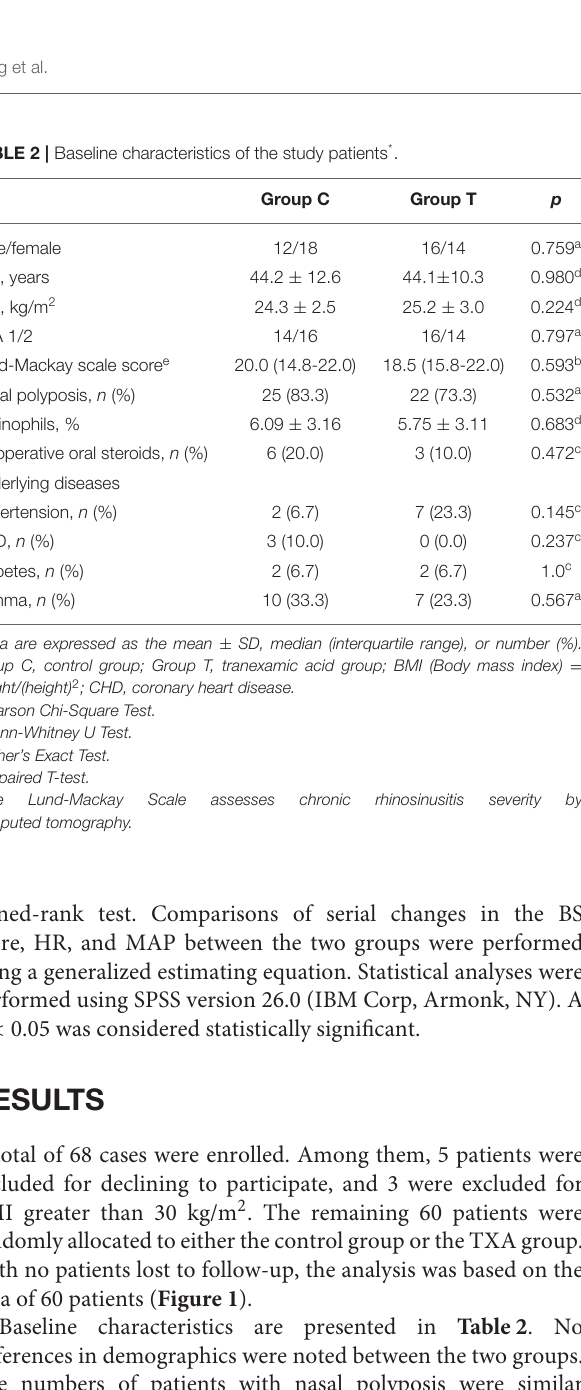
FIGURE 2 | The Boezaart scores (A) , TBL (B) , BT (C) , and OT (D) were compared by the Mann-Whitney U test for comparisons between the two groups. The line in the middle represents the median value for each group, and the upper and lower bars represent the 25th and 75th percentiles, respectively.